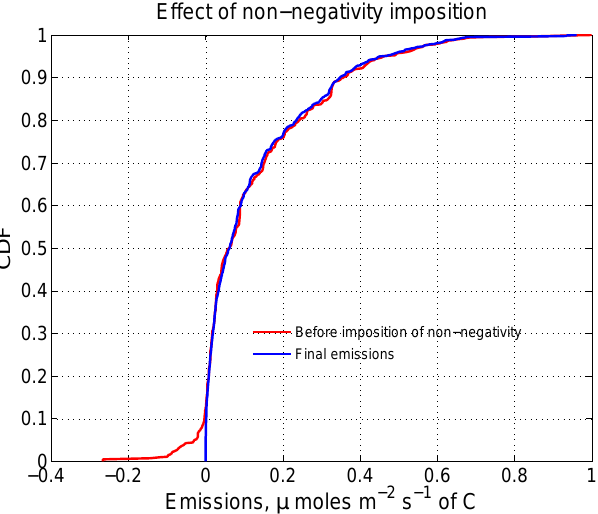
Figure 7. CDF of emissions in R , before and after the imposition of non-negativity, as described in Sect. 4. We see that the CDF of the emissions without non-negativity imposed contains a few grid cells with negative fluxes; further, the magnitude of the negative emis- sions is small. Thus the spatial parameterization, with sparse recon- struction, provides a good approximation of the final, non-negative